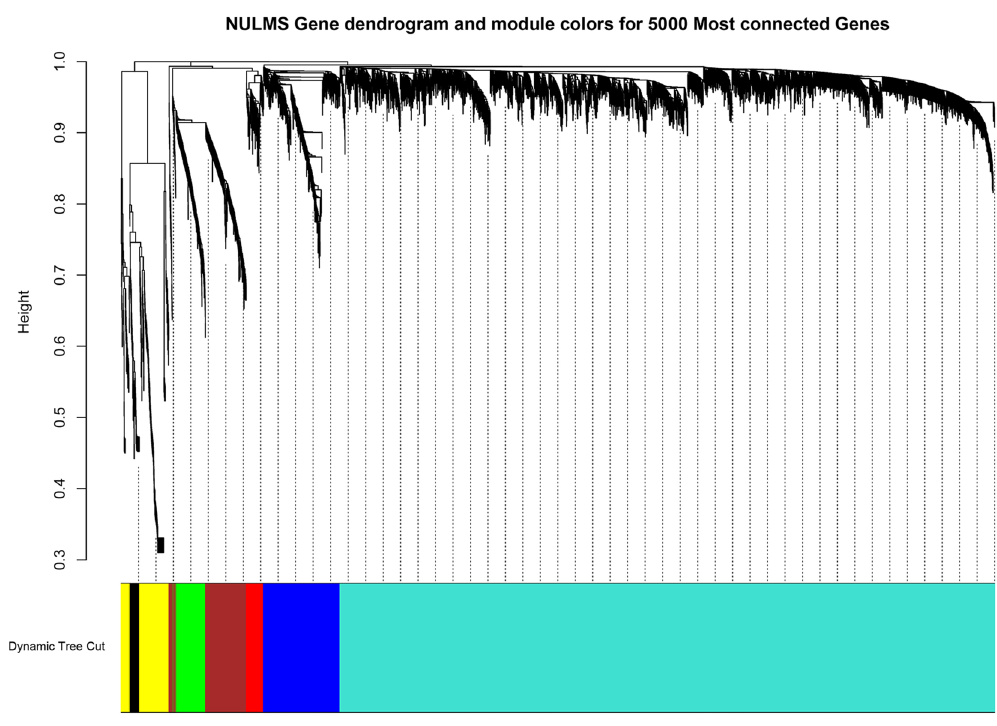
Figure 2. Gene dendrogram and module colors for TCGA